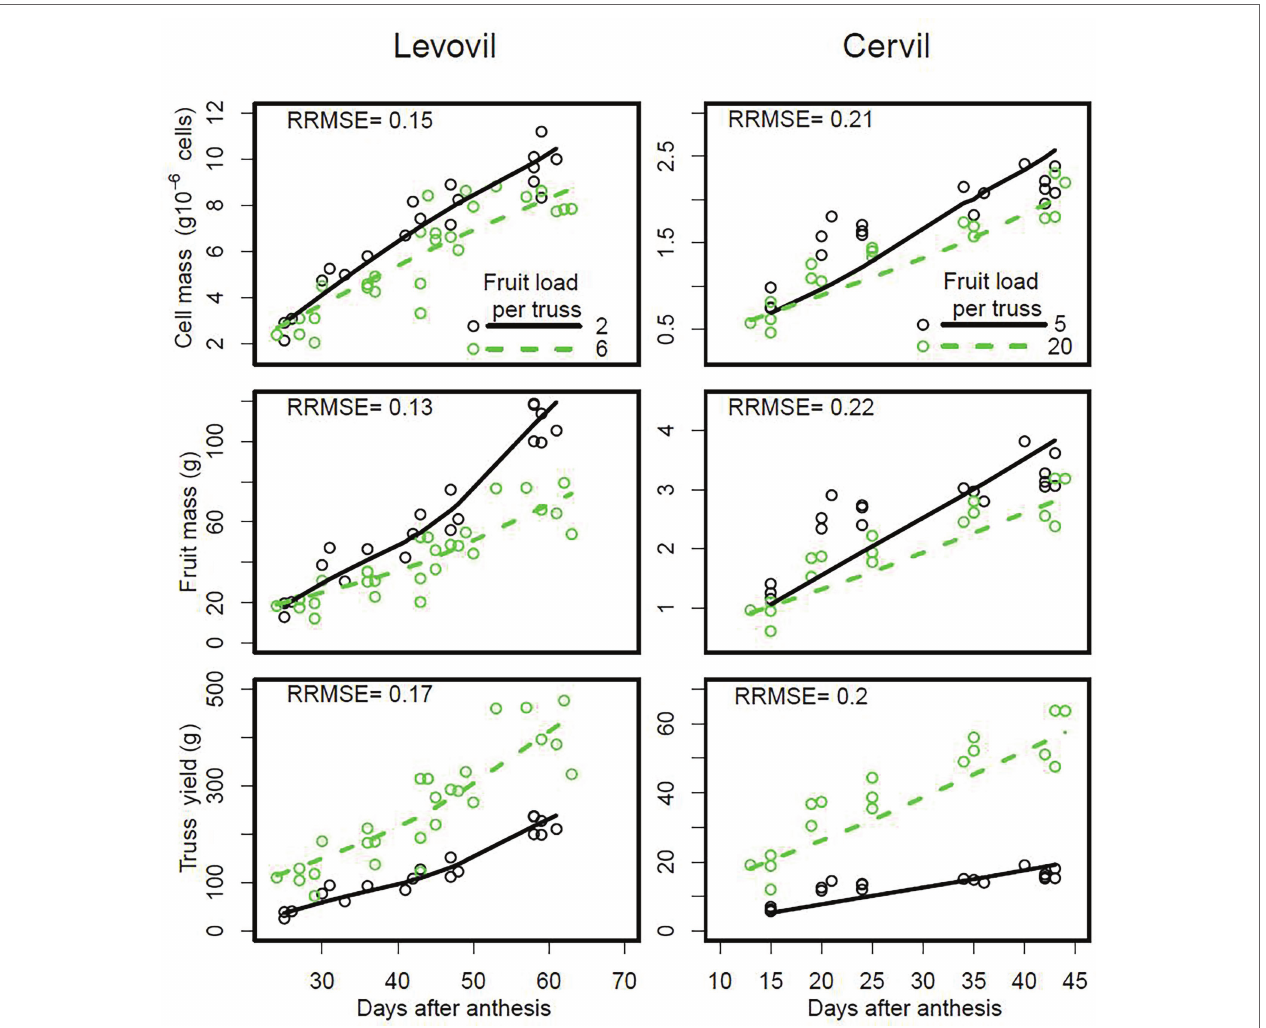
FIGURE 5 | Seasonal variation of cell and fruit masses and total yield of trusses, according to the tomato fruit load in the truss for the cultivars Levovil and Cervil. The points are measured data and the lines are smoothings of DDM predictions. On the plots of the second and third line, each fruit or truss, respectively, has a given number of cells or fruit, respectively (model inputs based on